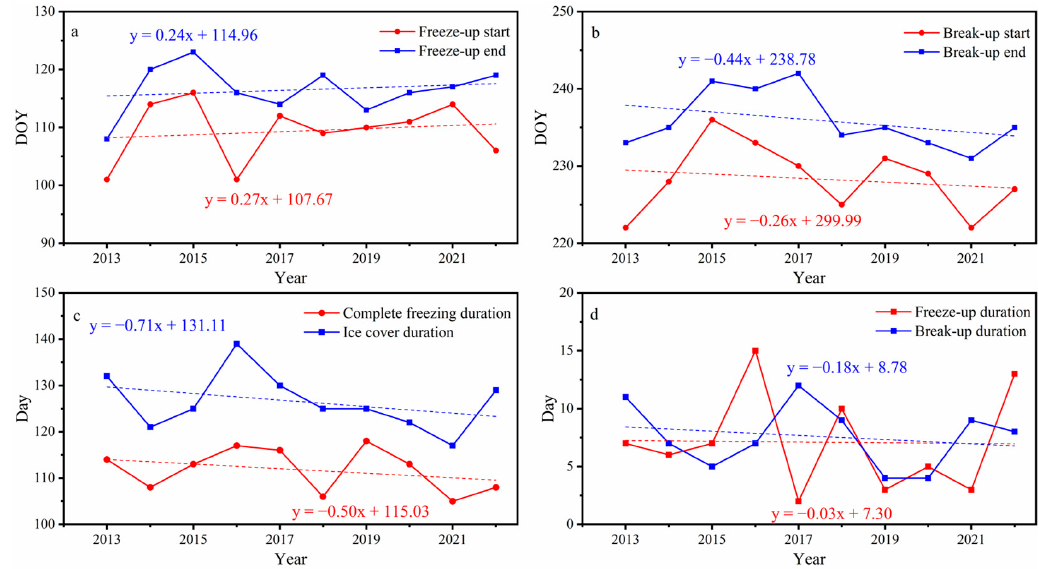
Figure 10. The ice phenology characteristics and their trends for Wuliangsu Lake from 2013 to 2022. ( a ) Freeze-up dates and their trends. ( b ) Break-up dates and their trends. ( c ) Complete freezing duration and ice cover duration and their trends. ( d ) Freeze-up and break-up durations and their trends. (Date is based on the annual cumulative day method, for example, 14 November 2021 is the 106th day of 2022).